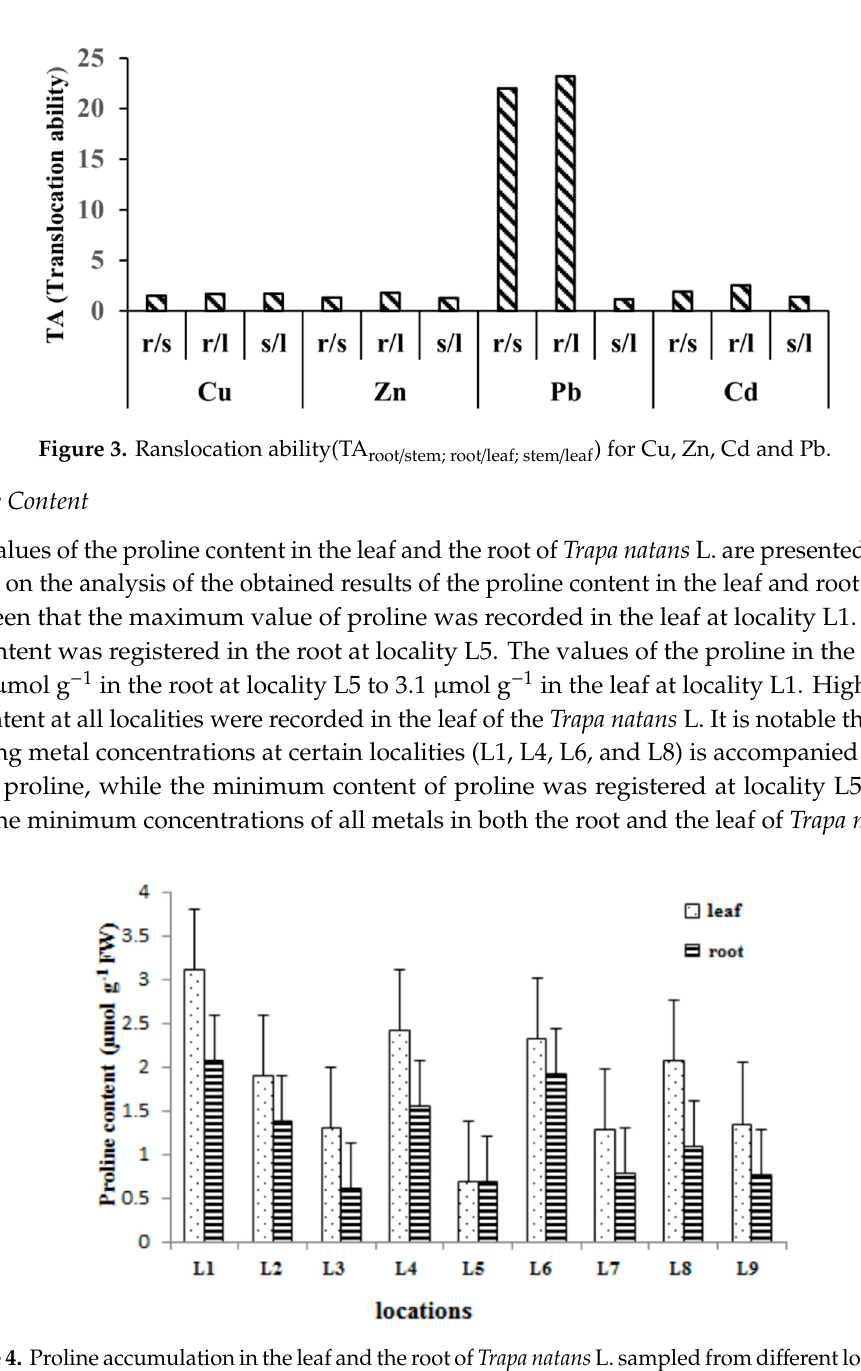
Figure 3. ranslocation ability(TA root/stem; root/leaf; stem/leaf ) for Cu, Zn, Cd and Pb.